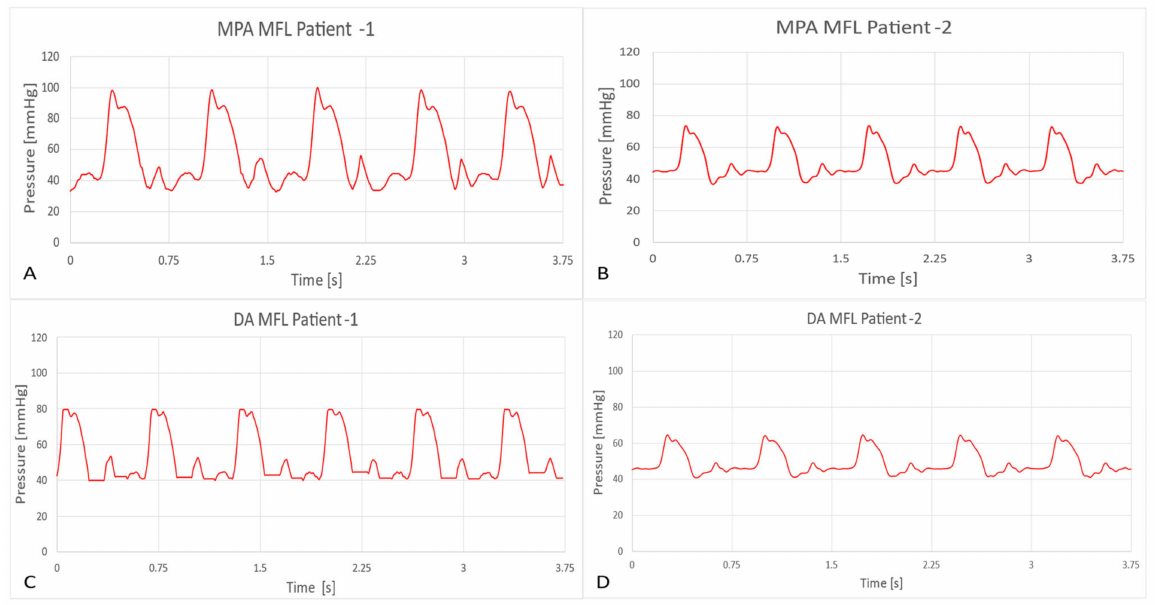
Figure 21. In-vitro measurements of pressure waveforms in the MPA ( A , B ) and DA ( C , D ) conduits for patients 1 and 2.